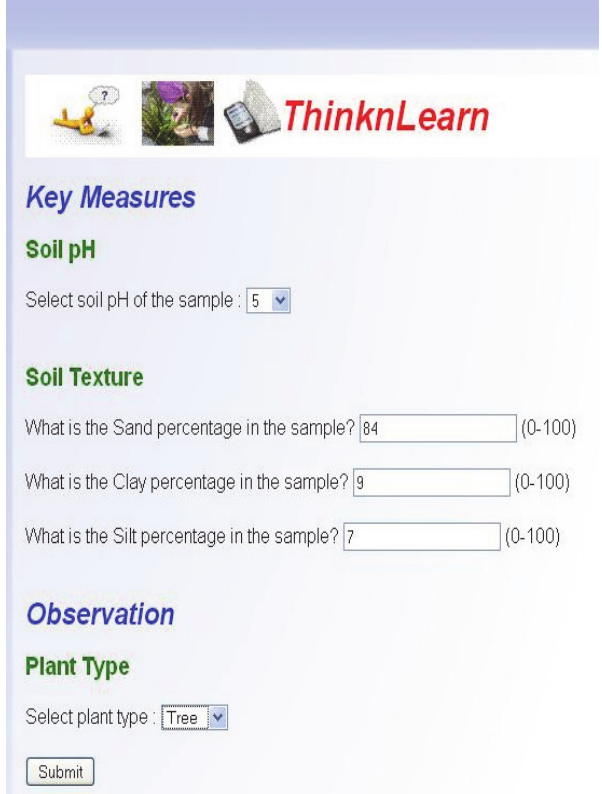
Figure 5 . Measurements and observation.